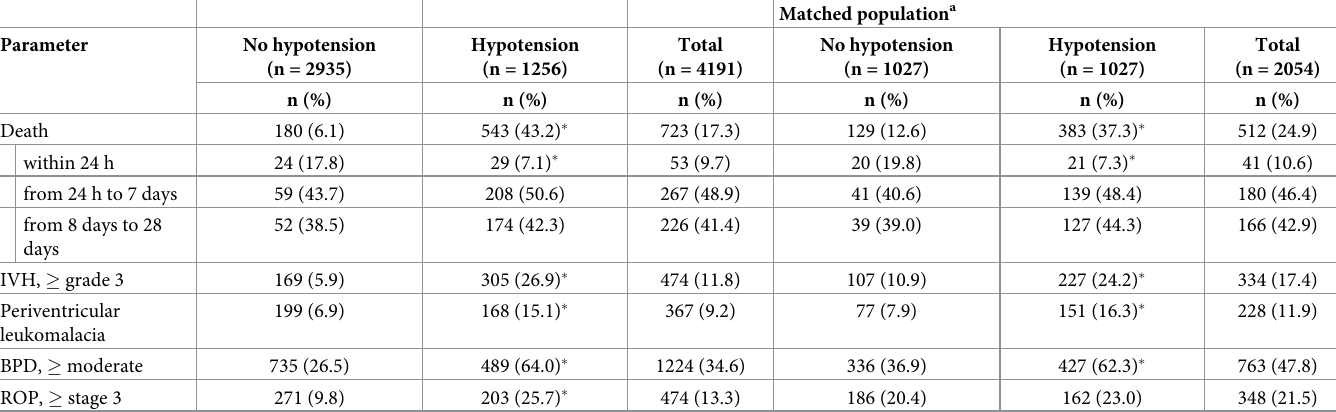
Matched population a